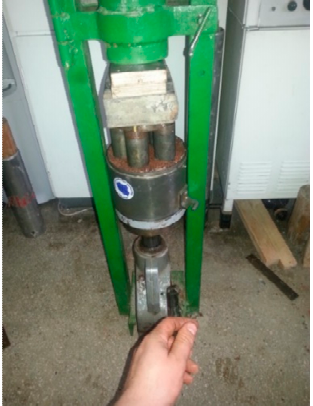
Figure 2. Preparation of specimens from the red clay–rubber (RC-R) mixture.